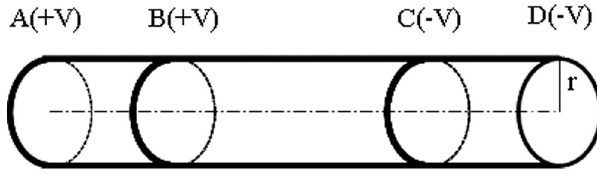
FIG. 9. Geometry of the EO-effect